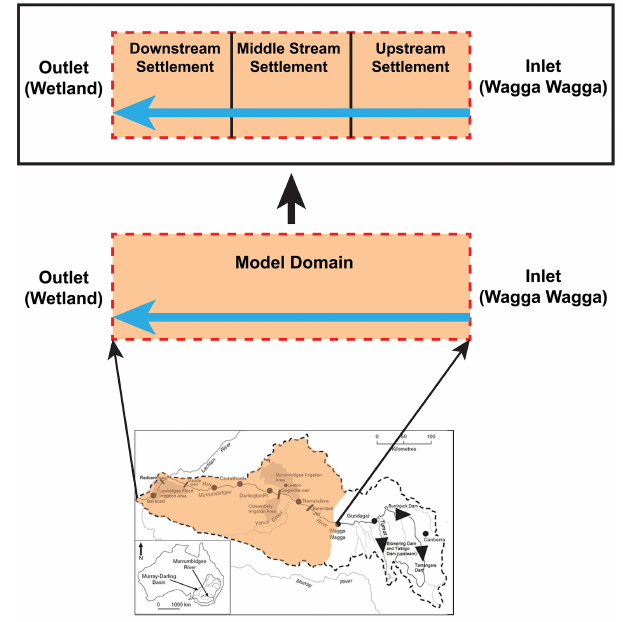
Figure 2. Model domain and the discretization into three settle- ments (downstream, middle stream and